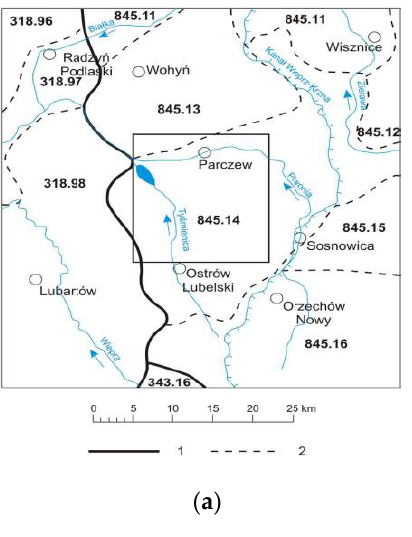
Figure 1. Location of Parczew against the background of physico-geographical units. ( a ) Province: East Baltic-Belarusian Low, Sub-province: Polesie. ( b ) Location on the map of the Parczew commune in the Western Polesie macroregion belonging to the Polesie sub-province, which is part of the Eastern Baltic-Belarusian Lowland province.